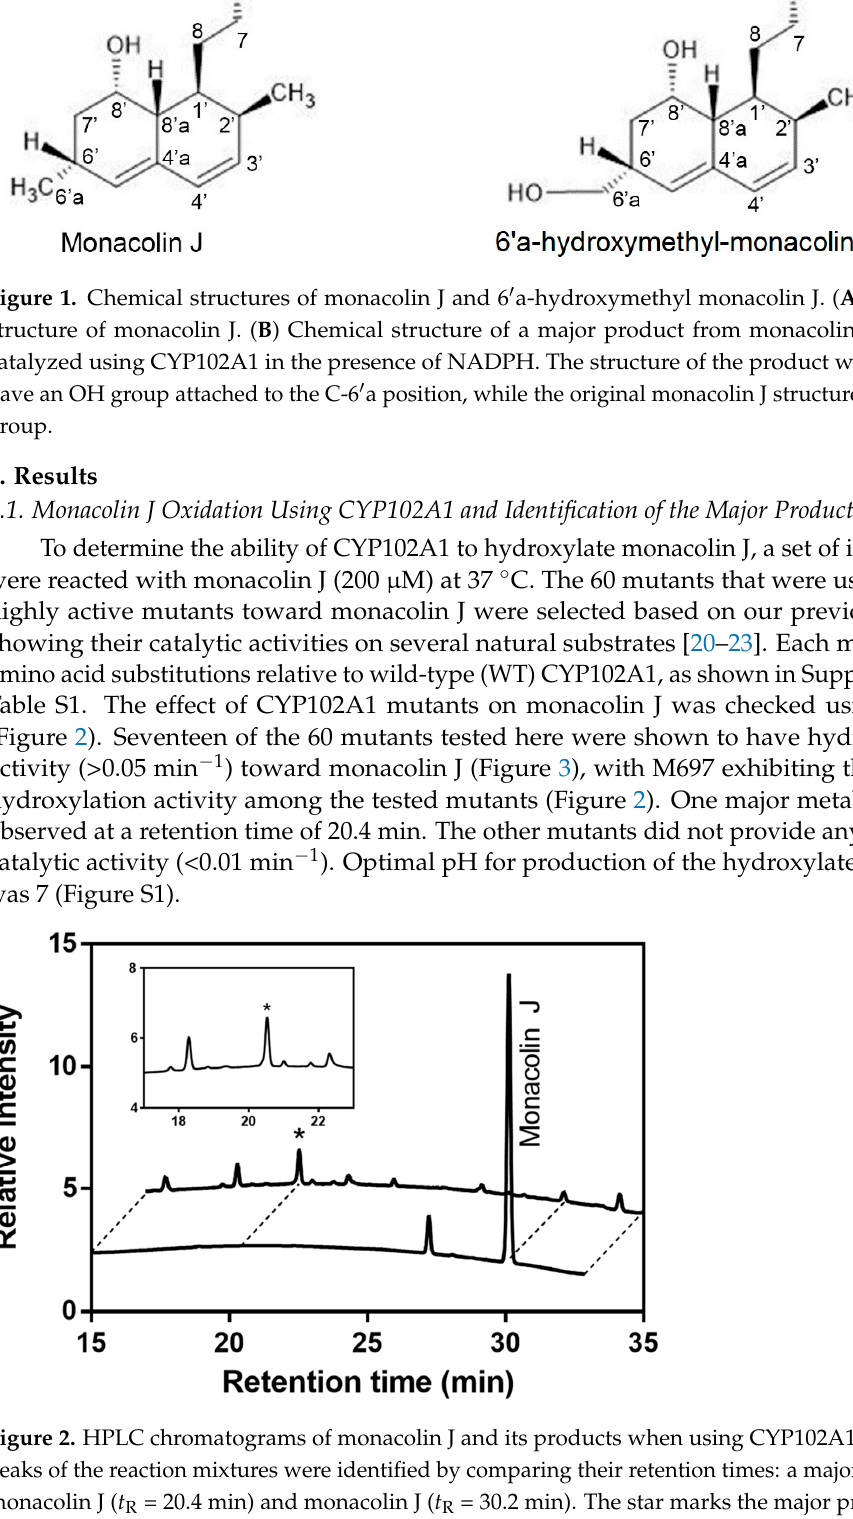
0 Figure 3. Hydroxylation rate of the monacolin J catalyzed using CYP102A1 mutants. The M697 showed the highest hydroxylation activity among the tested mutants. The rates of the major product formation using 17 mutants are presented as the mean ± SEM of triplicate measurements. To characterize the chemical structure of the major product, the reaction was ana- lyzed using LC–MS (Figure 4). A full-scan chromatogram of the reaction mixture of mon- acolin J with M697 showed that monacolin J (Figure 4A) was converted to several products (Figure 4B). The results of the LC–MS analysis indicated that the major product ( m/z = 359) ( t R = 20.42 min) was hydroxylated (Figure 4D) when compared to the substrate, namely, monacolin J ( m/z = 343) (Figure 4C).